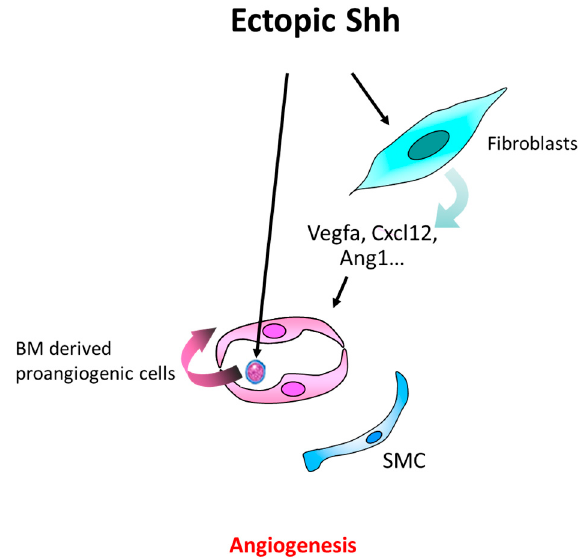
Figure 5. Schema representing the main cellular events underlying the proangiogenic effect of Shh therapy in the setting of ischemia. When administered ectopically in ischemic tissues, Shh promotes angiogenesis indirectly by upregulating Vegfa, Cxcl12, and Angpt1 in fibroblasts and by recruiting bone marrow-derived proangiogenic cells.